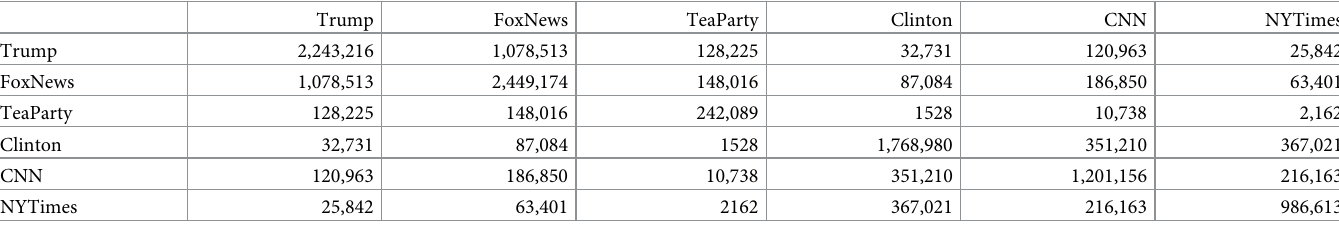
Table 2. Affiliation matrix